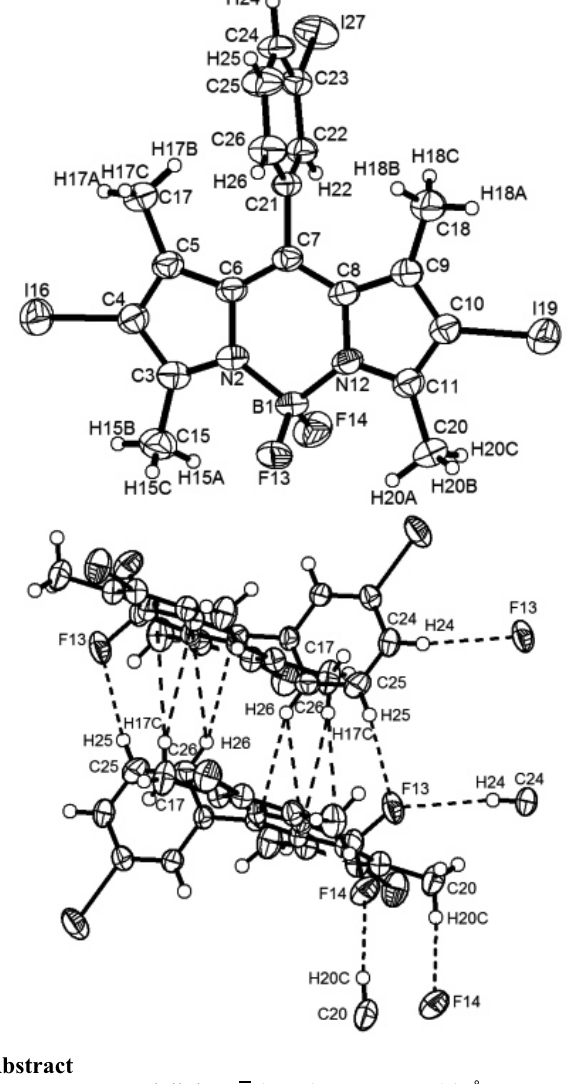
Table 1. Data collection and